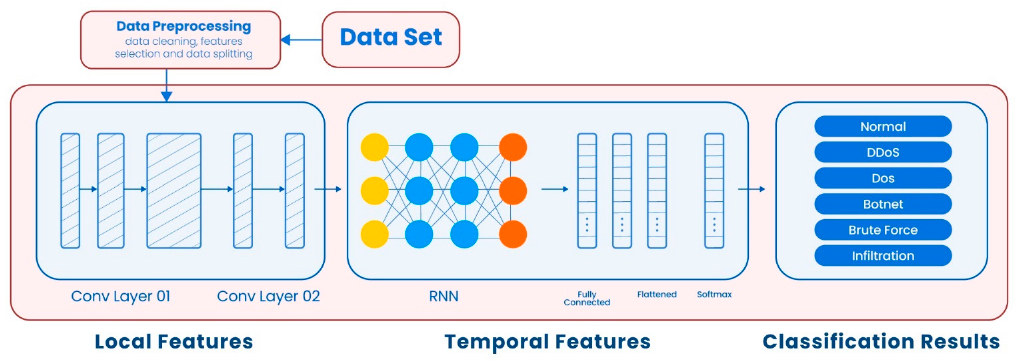
Figure 1. Proposed HDLNIDS model.